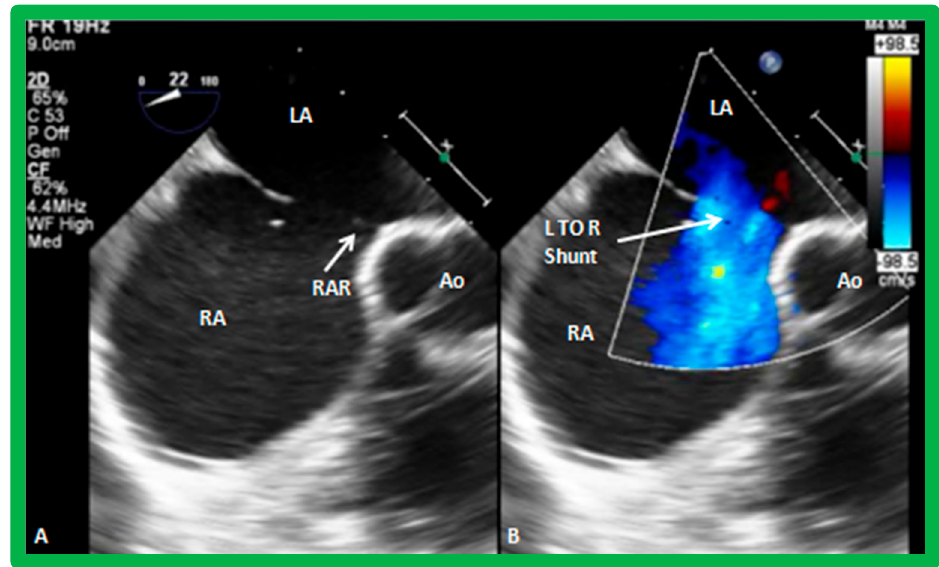
Figure 15. Transesophageal echocardiographic (TEE) images of an atrial septal defect (ASD) in a short-axis projection. An extremely small retro-aortic (RAR) (anterio-superior) rim in ( A ) is seen. Left-to-right (L to R) shunt through the atrial defect by color Doppler is shown in ( B ). Ao, aorta; LA, left atrium; RA, right atrium.